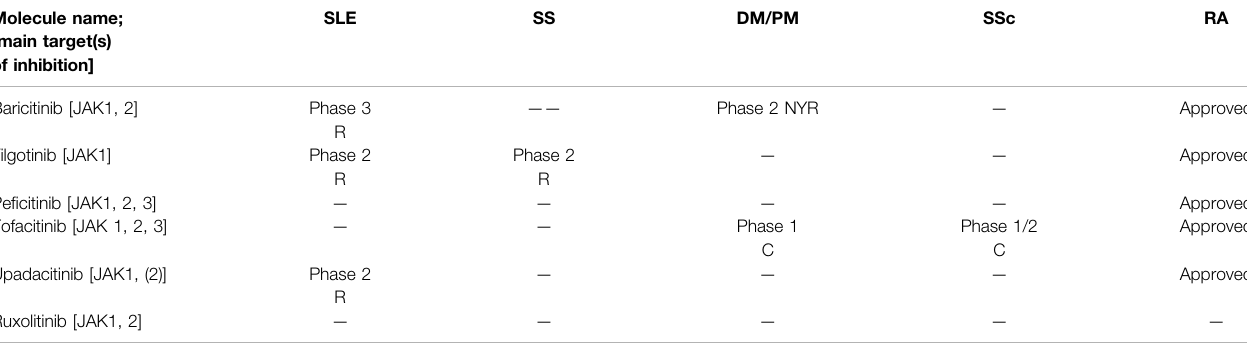
TABLE 4| CurrentphaseofdevelopmentofJanuskinaseinhibitors insystemicautoimmunediseases(based onhttps://clinicaltrials.gov/accessedonNovember11,2020). Molecule name; [main target(s) of